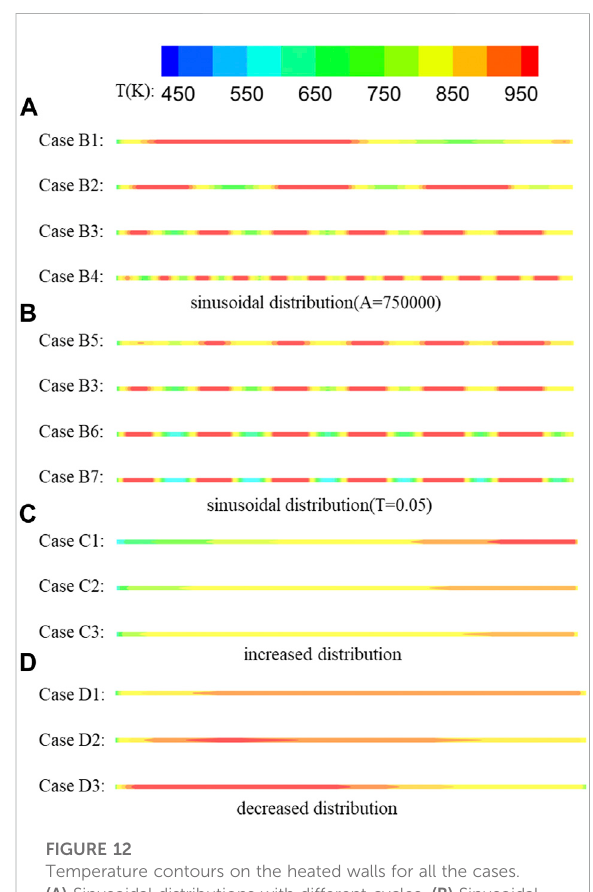
FIGURE 12 Temperature contours on the heated walls for all the cases. (A) Sinusoidal distributions with different cycles. (B) Sinusoidal distributions with different amplitudes. (C) Increased heat fl ux distributions. (D) Decreased heat fl ux